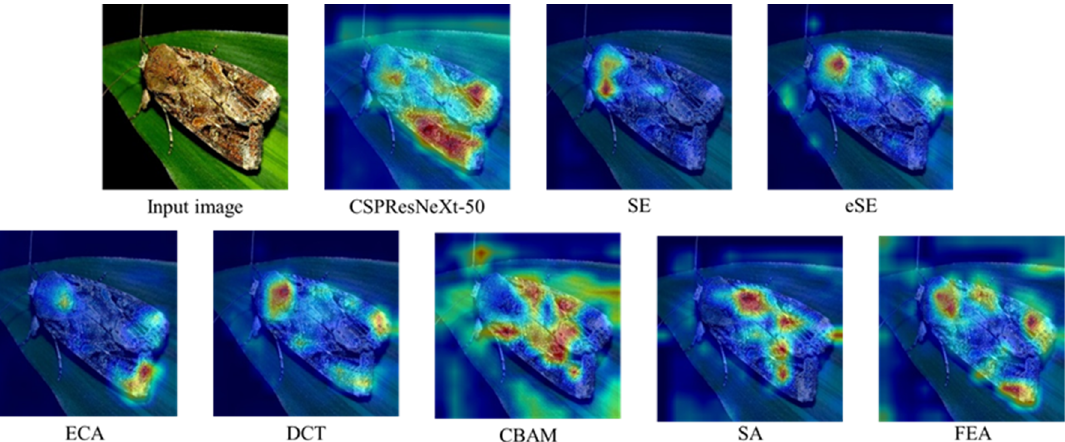
Figure 9. Convolutional visualization of different attention methods in the last layer of third CSP ‐ stage.